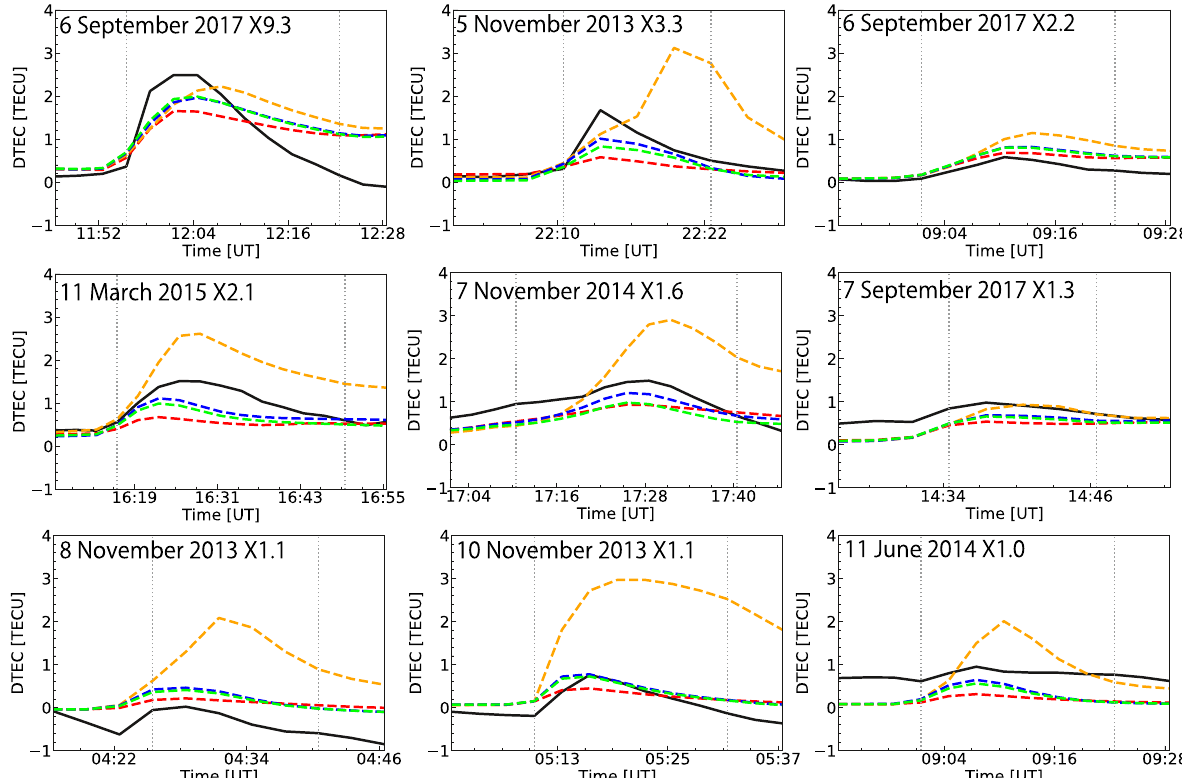
Fig. 7 Time variation of DTEC for the events analyzed in this study. The time variation of DTEC for the nine flare events analyzed in this study during the flare occurrence. The solid black, dashed red, dashed orange, dashed blue, and dashed green lines indicate the DTEC obtained from observations, RUN-Ff, RUN-FS35, RUN-FS15, and RUN-FS10, respectively. The observed and calculated DTEC were obtained at points, where the local time was around noon when each flare event occurred. The vertical dotted lines indicate, from left to right, the flare start and end times,